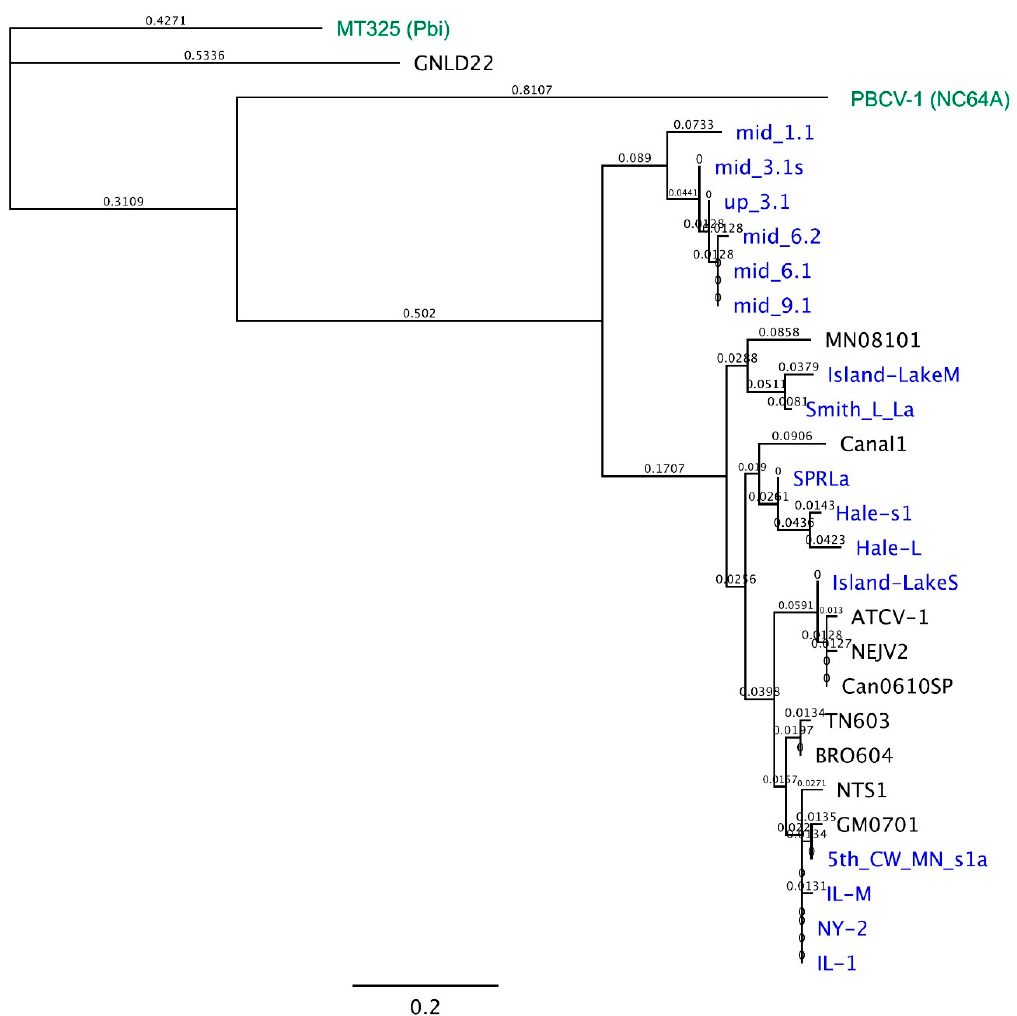
Figure 3. Phylogenetic tree of Kcv proteins from 26 SAG chloroviruses. PhyML, which is Maximum likelihood, with the default settings was used to construct the tree. The branch length shows dissimilarity between strains and the values on the branches are the number of changes. The viruses in blue represent the new Kcv proteins reported in this manuscript. Viruses MT325 representing a Pbi virus and PBCV-1 representing an NC64A virus are in green. Additional information on each of the Kcv proteins from the SAG viruses, including where they were isolated and the number of times that protein sequence appeared, is included in Table A1.